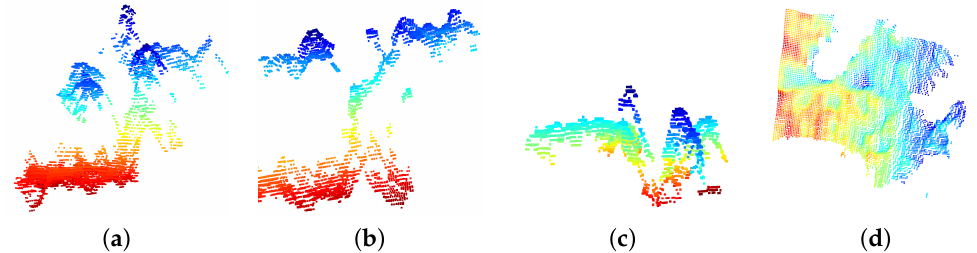
Figure 9. Object segmentation dataset. ( a – c ) The first, second, and third stage seedlings, respectively. ( d ) An empty cavity where the seedling did not